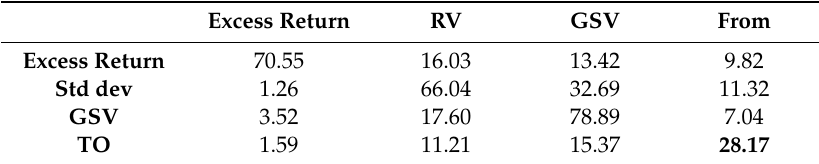
Table 6. Total spillover, Croatia.